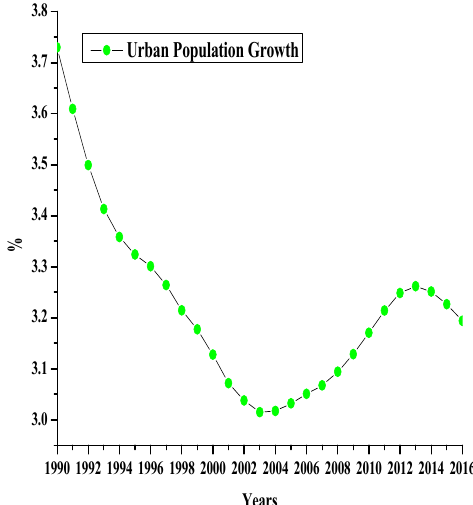
Figure 6. Urban Population Growth in Pakistan.